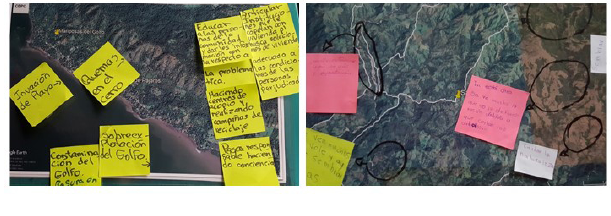
Fig. 8 . Sample output from Stage 1 of the model-based reasoning workshop small groups in Costa de Pájaros (left) and Santa Rosa (right).